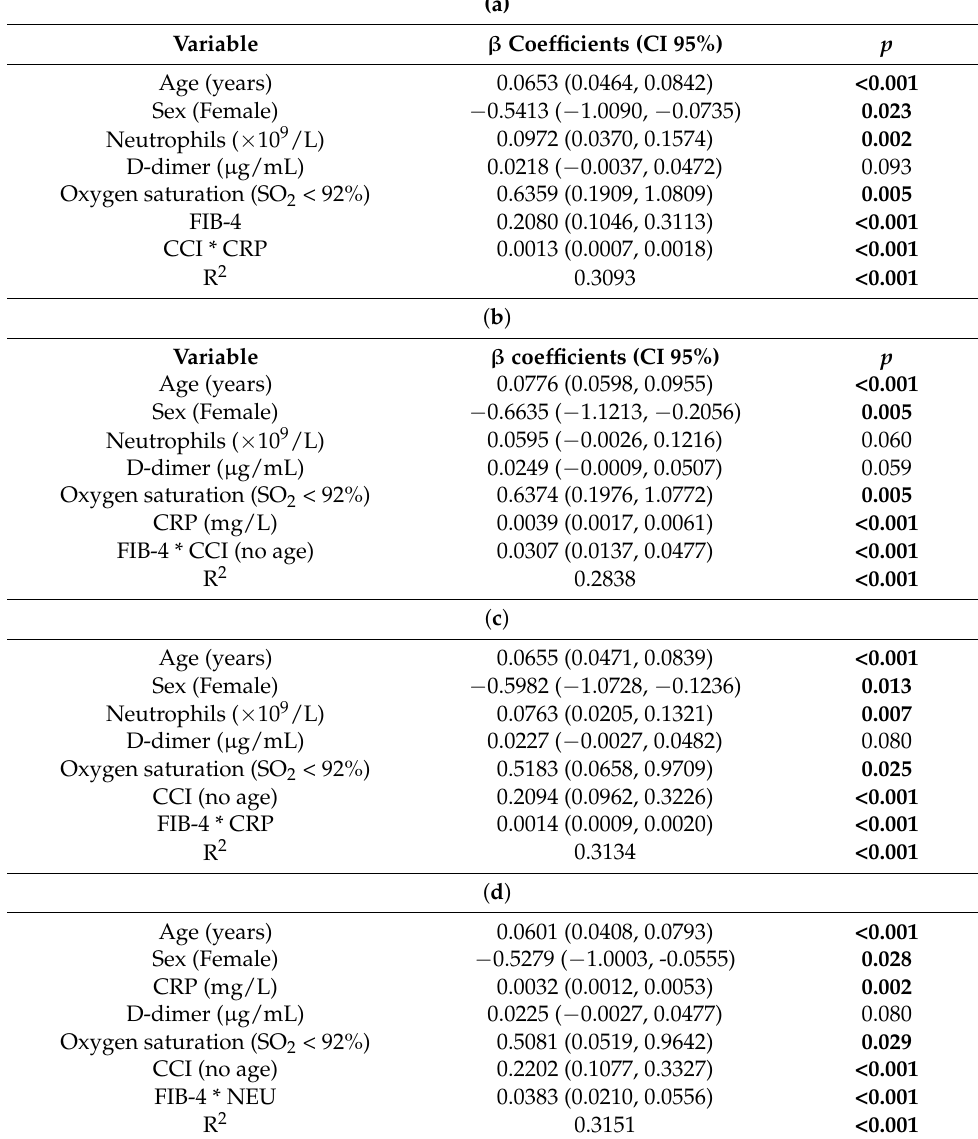
Table 3. ( a ) Multiple logistic regression model using clinical, inflammatory and liver markers as important predictors of mortality plus ICU in COVID-19 patients: interaction between CCI and CRP. ( b ) Multiple logistic regression model using clinical, inflammatory and liver markers as important predictors of mortality plus ICU in COVID-19 patients: interaction between FIB-4 and CCI. ( c ) Multiple logistic regression model using clinical, inflammatory and liver markers as important predictors of mortality plus ICU in COVID-19 patients: interaction between FIB-4 and CRP. ( d ) Multiple logistic regression model using clinical, inflammatory and liver markers as important predictors of mortality plus ICU in COVID-19 patients: interaction between FIB-4 and